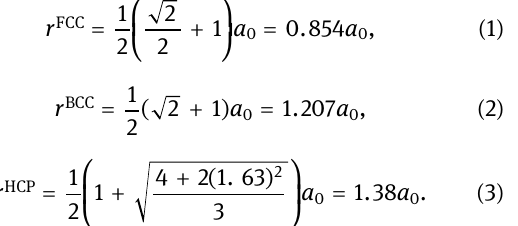
Figure 2: Total energy fl uctuations during relaxation stage.